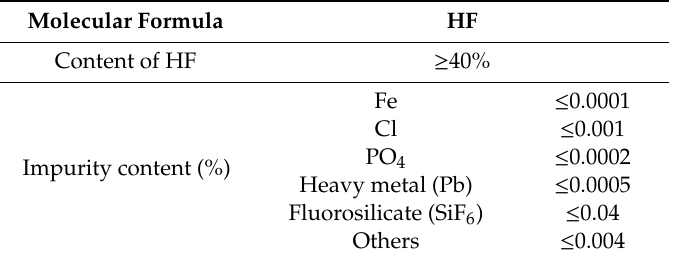
Table 4. The chemical composition of hydrofluoric acid.